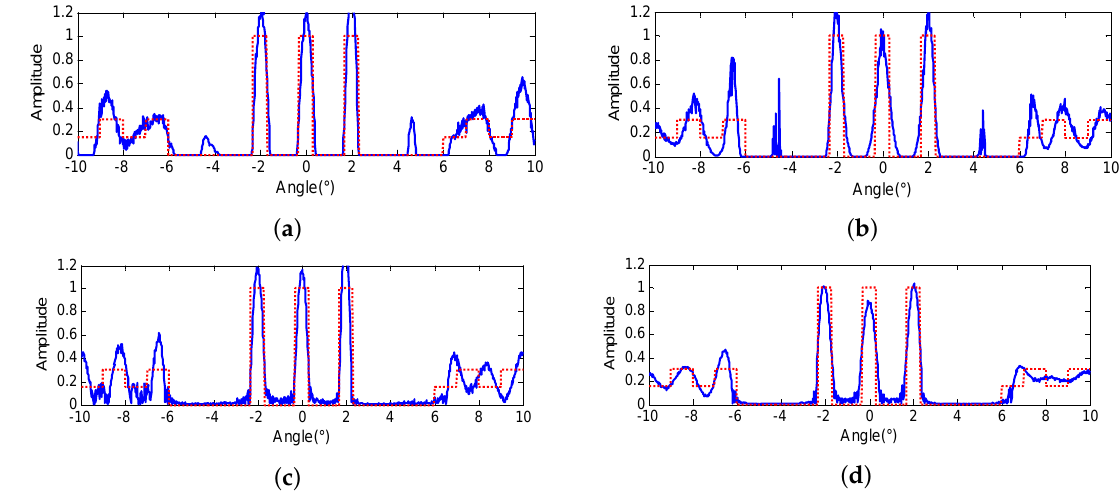
Figure 6. Super-resolution results of ( a ) Landweber ( b ) Richardson-Lucy (RL) ( c ) maximum a posterior (MAP) ( d ) proposed penalized maximum likelihood (PML) when the ISV equals 0.95 κ with SNR = 20